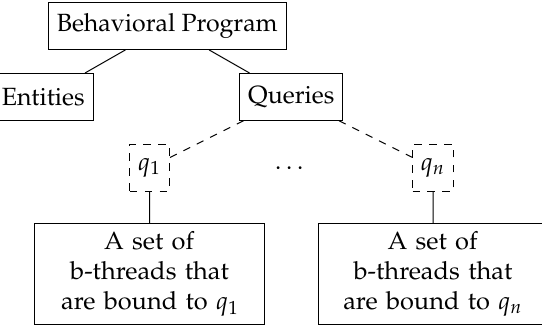
Figure 1. Structure of a general COBP